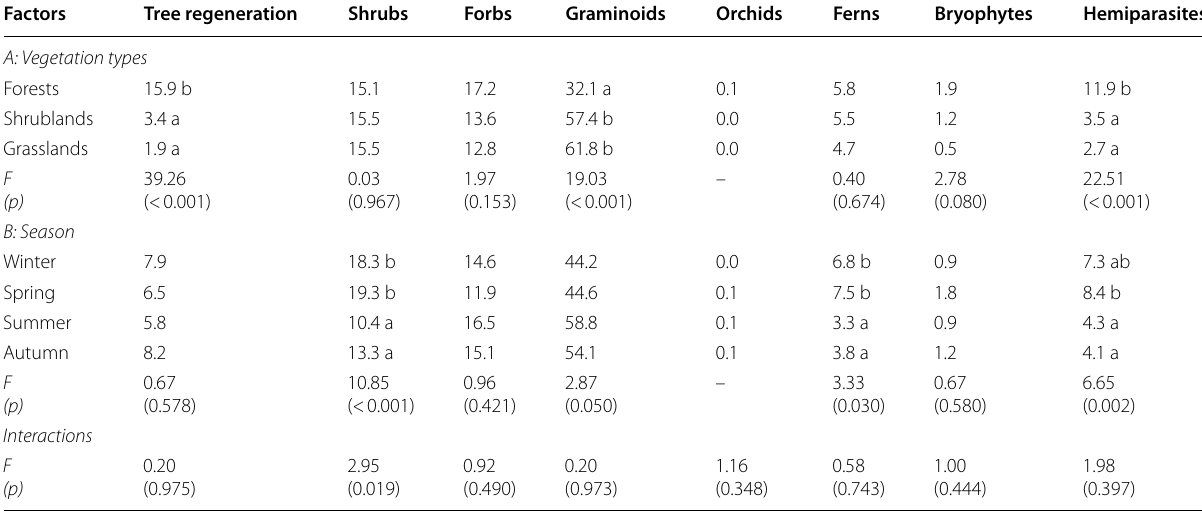
Table 2 Average rabbit forage intakes by plant life form (%), two‑way ANOVA and Tukey test results, at each studied vegetation type and along the four seasons of the year